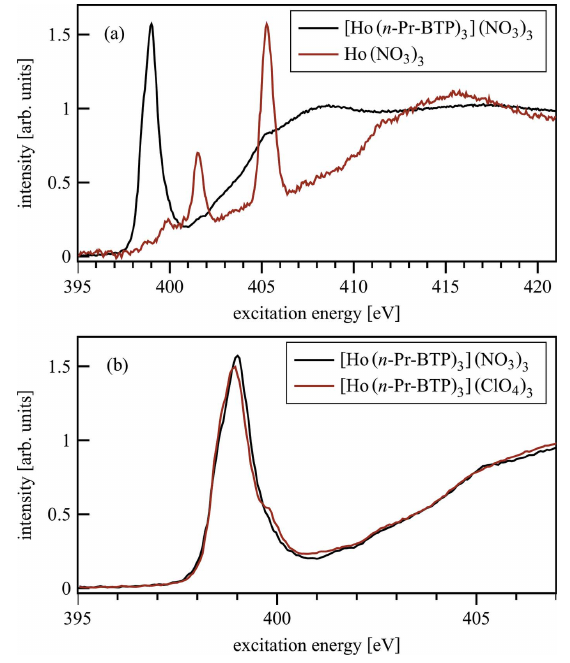
Figure 18 The contribution of NO (cid:2)